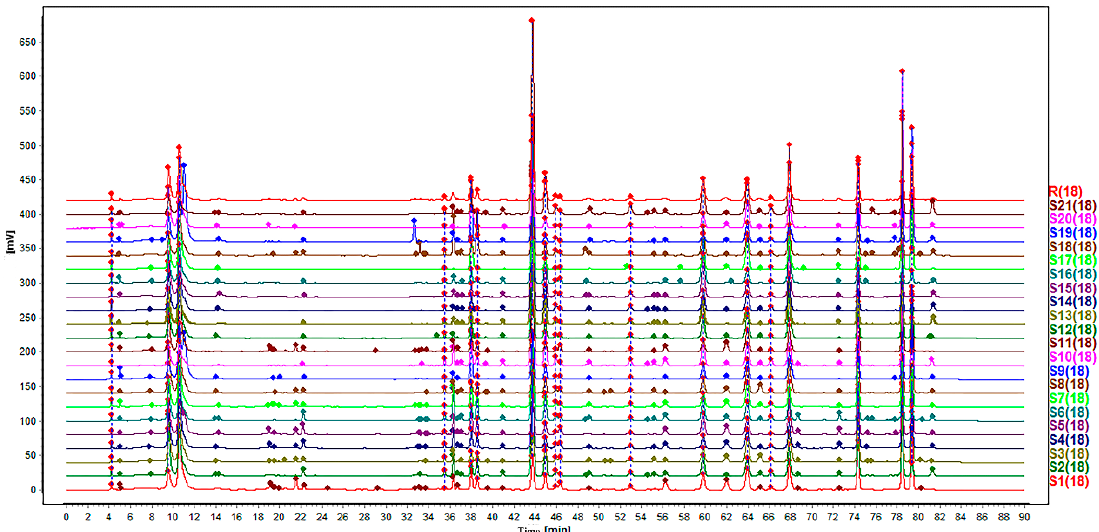
Figure 1. HPLC fingerprints of the 21 batches of toad venom extracts.